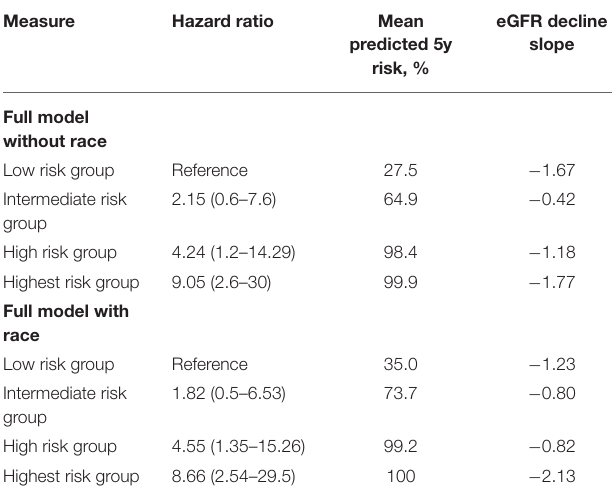
TABLE 3 | Discrimination measures in the current and reported